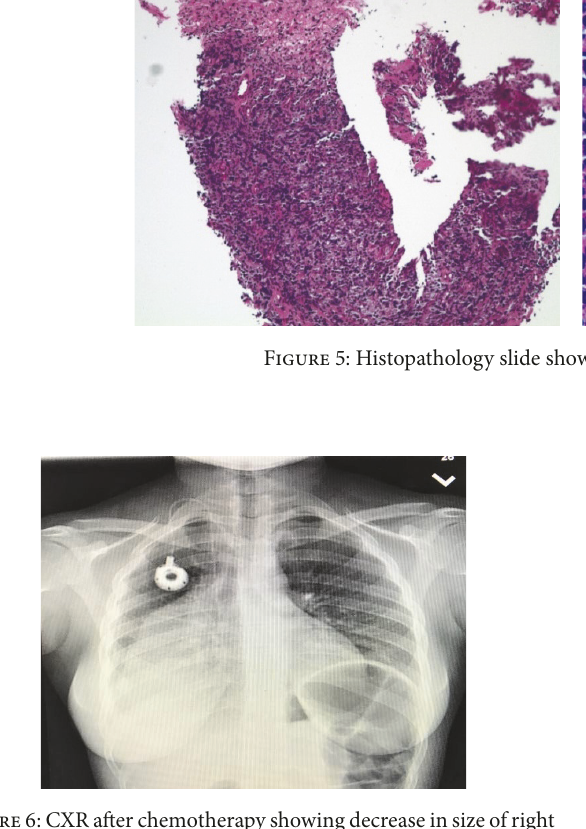
Figure 6: CXR after chemotherapy showing decrease in size of right lung